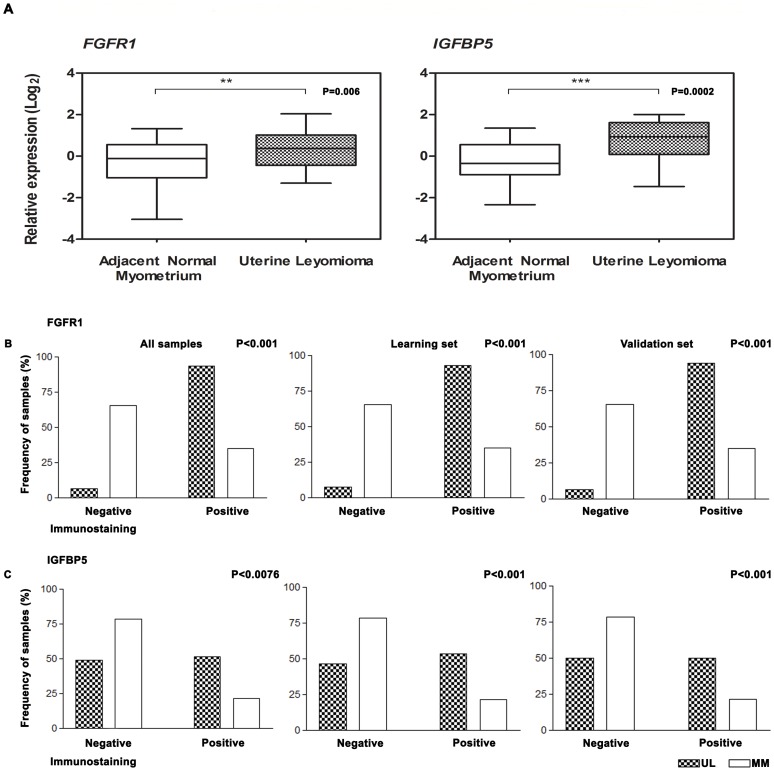
Data validation.(A) Boxplot illustrating MM (normal) and ULs (tumour) normalised to obtain relative expression values for all samples evaluated by RT-qPCR. P = paired t test significance. **P = 0.006; ***P = 0.0002; Immunostaining frequency for the (B) FGFR1 and (C) IGFBP5 proteins. The P values (Fisheŕs test) were obtained based on the comparison of the MM and ULs immunostaining results.